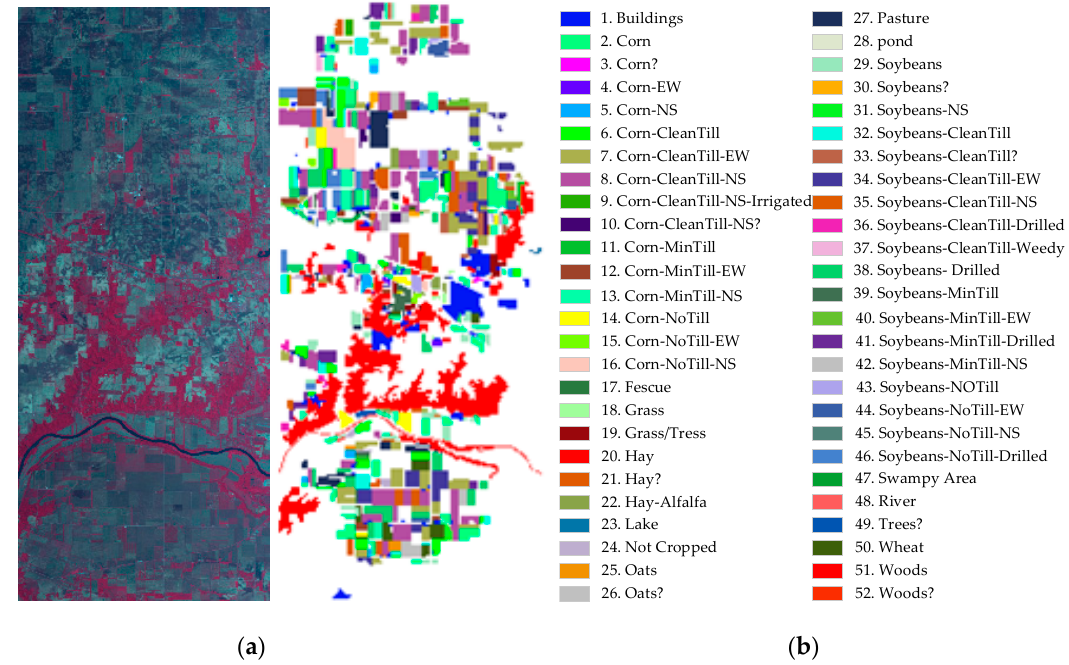
Figure 4. The Indian Pines dataset. ( a ) False-color composite image (Band 40, 25, 10); ( b ) ground reference map.